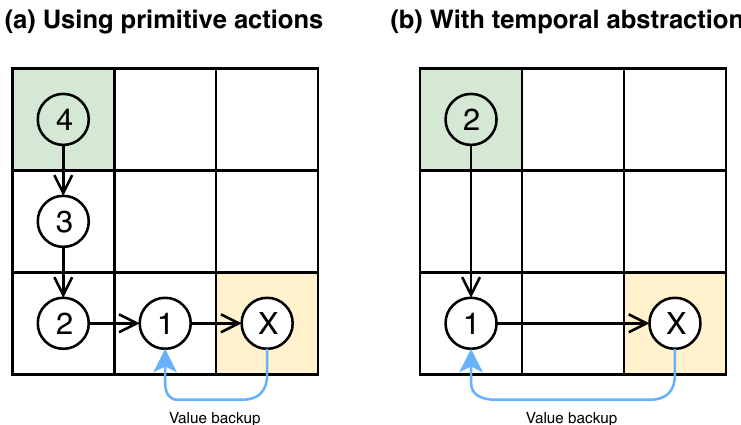
Figure 4. Value backups, ( a ) using primitive actions, and ( b ) using temporal abstractions. With temporal abstractions an optimal policy can be found using less value backups.